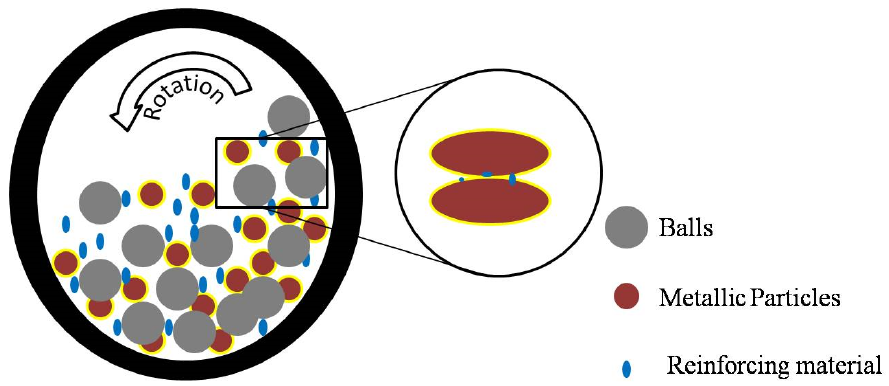
Figure 1. Schematic of metallic nanocomposite ball milling process. Inserted: the particle embedded onto the interfacial boundaries of the metallic matrix after mechanical alloying.